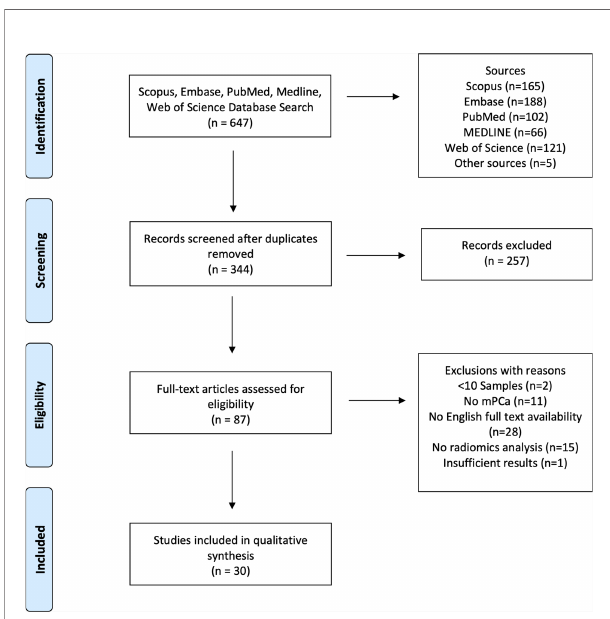
FIGURE 2 | PRISMA fl ow diagram showing the study inclusion and exclusion process.